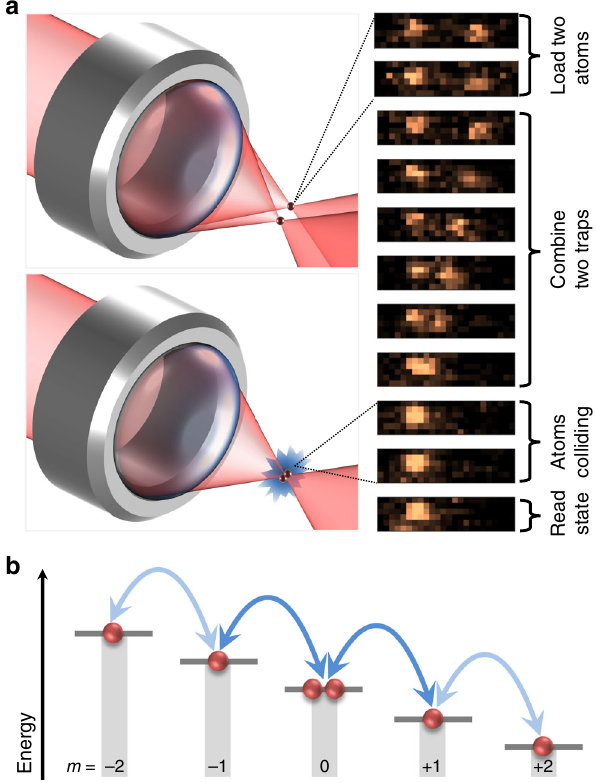
Fig. 1 Experimental schematics. a (Left) Two optical tweezers are formed using the high-numerical-aperture lens. By reducing the separation between the tweezers and then turning one of the tweezers off, both atoms are transferred into the same optical tweezer, allowing atomic collisions to occur. (Right) Superimposed fl uorescent images of the same two atoms showing their relative positions for different experimental stages. After combining the two traps, the individual atomic positions can no longer be resolved. b Spin-changing collisions: Two atoms initially in |0, 0 〉 can only couple to ^ S 1 ; (cid:2) 1 j i (dark arrows) and then to ^ S 2 ; (cid:2) 2 j i (light arrows), where the symmetrization operator ^ S is de fi ned in the main